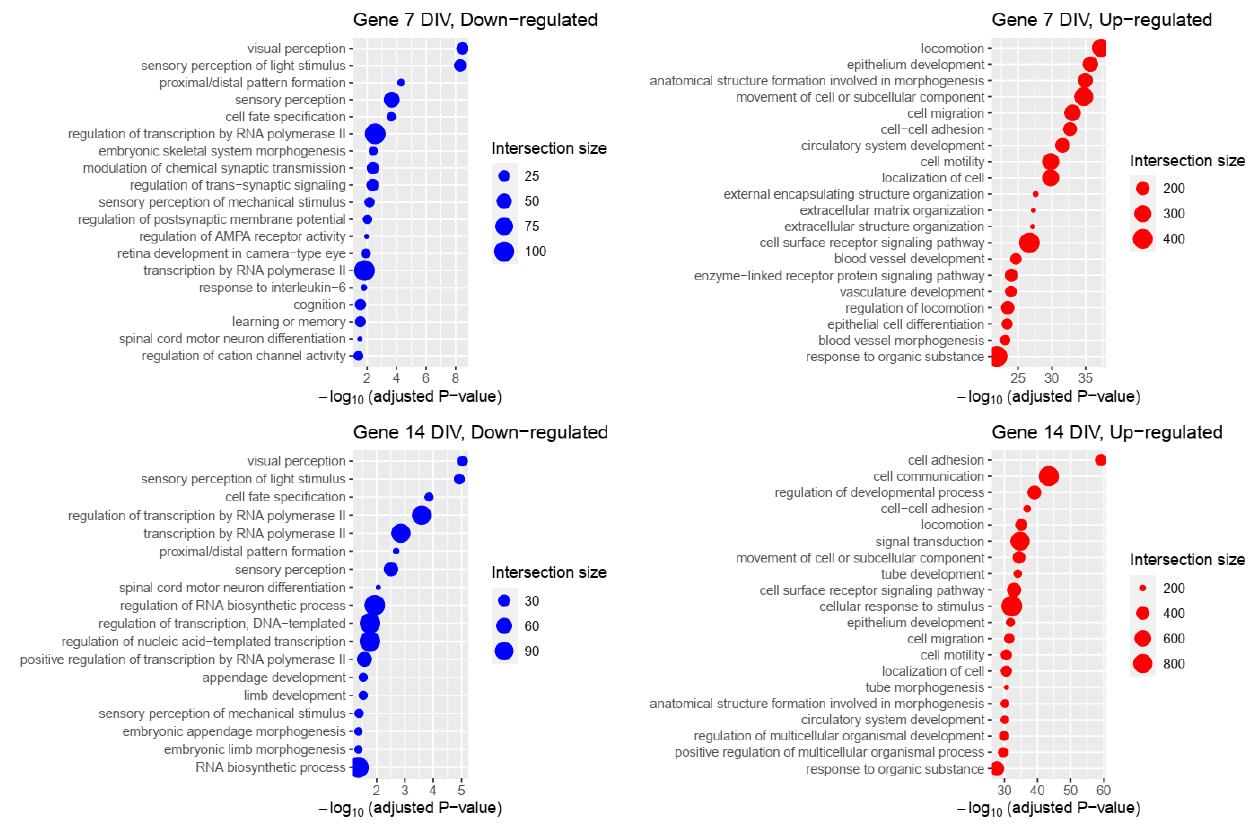
Figure 3. Biological process enrichment analysis of differentially expressed genes in iMNs TDP- 43 M337V . Top 20 enriched biological processes associated with differentially expressed (DE) genes, down-regulated (blue) and up-regulated (red) at each time point are shown. Each list goes in descending order according to their statistical significance. The dot size corresponds to the number of genes associated with the respective biological process (“Intersection size”).